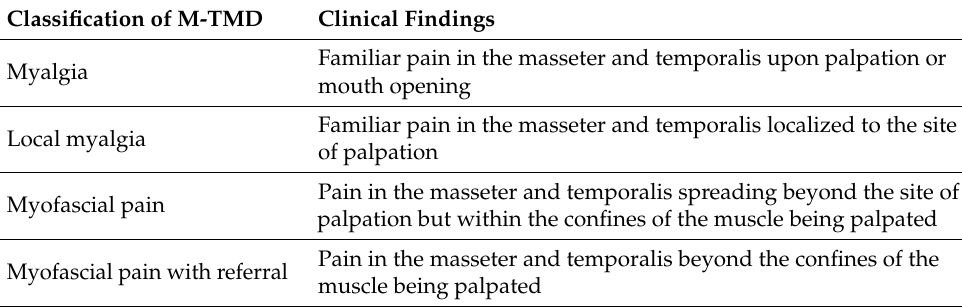
Table 2. Subdivision of myalgia according to the DC/TMD